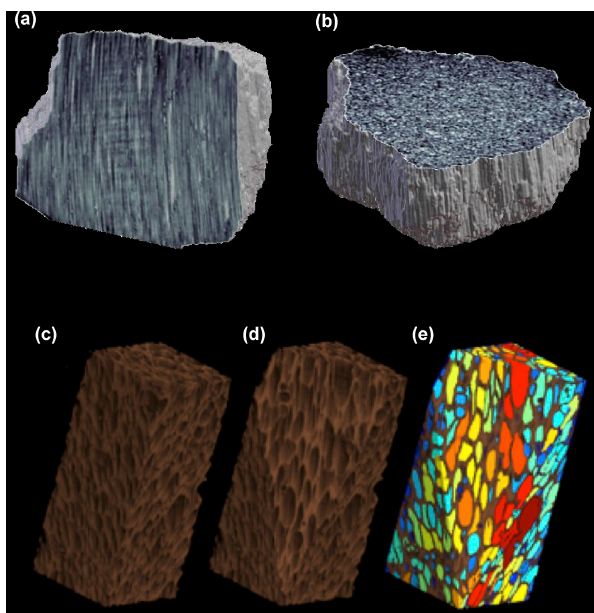
Figure 6. Neutron computed tomography (NCT) reconstruction of the tube pumice showing the internal structure of the tubular texture (a) in parallel and (b) perpendicular cross sections. (c) Rendering of a sub-volume taken from the tube pumice NCT. (d) Cutaway of the rendering shown in (c) , revealing some of the internal structure of the sub-volume. (e) A false-colour composite showing the re- sult of the segmentation algorithm. Here each pore has been colour- coded based on its volume, with small pores shaded blue increasing through the colour spectrum to large pores, which are shaded red; voxel size is 51.2 × 51.2 × 51.2µm 3